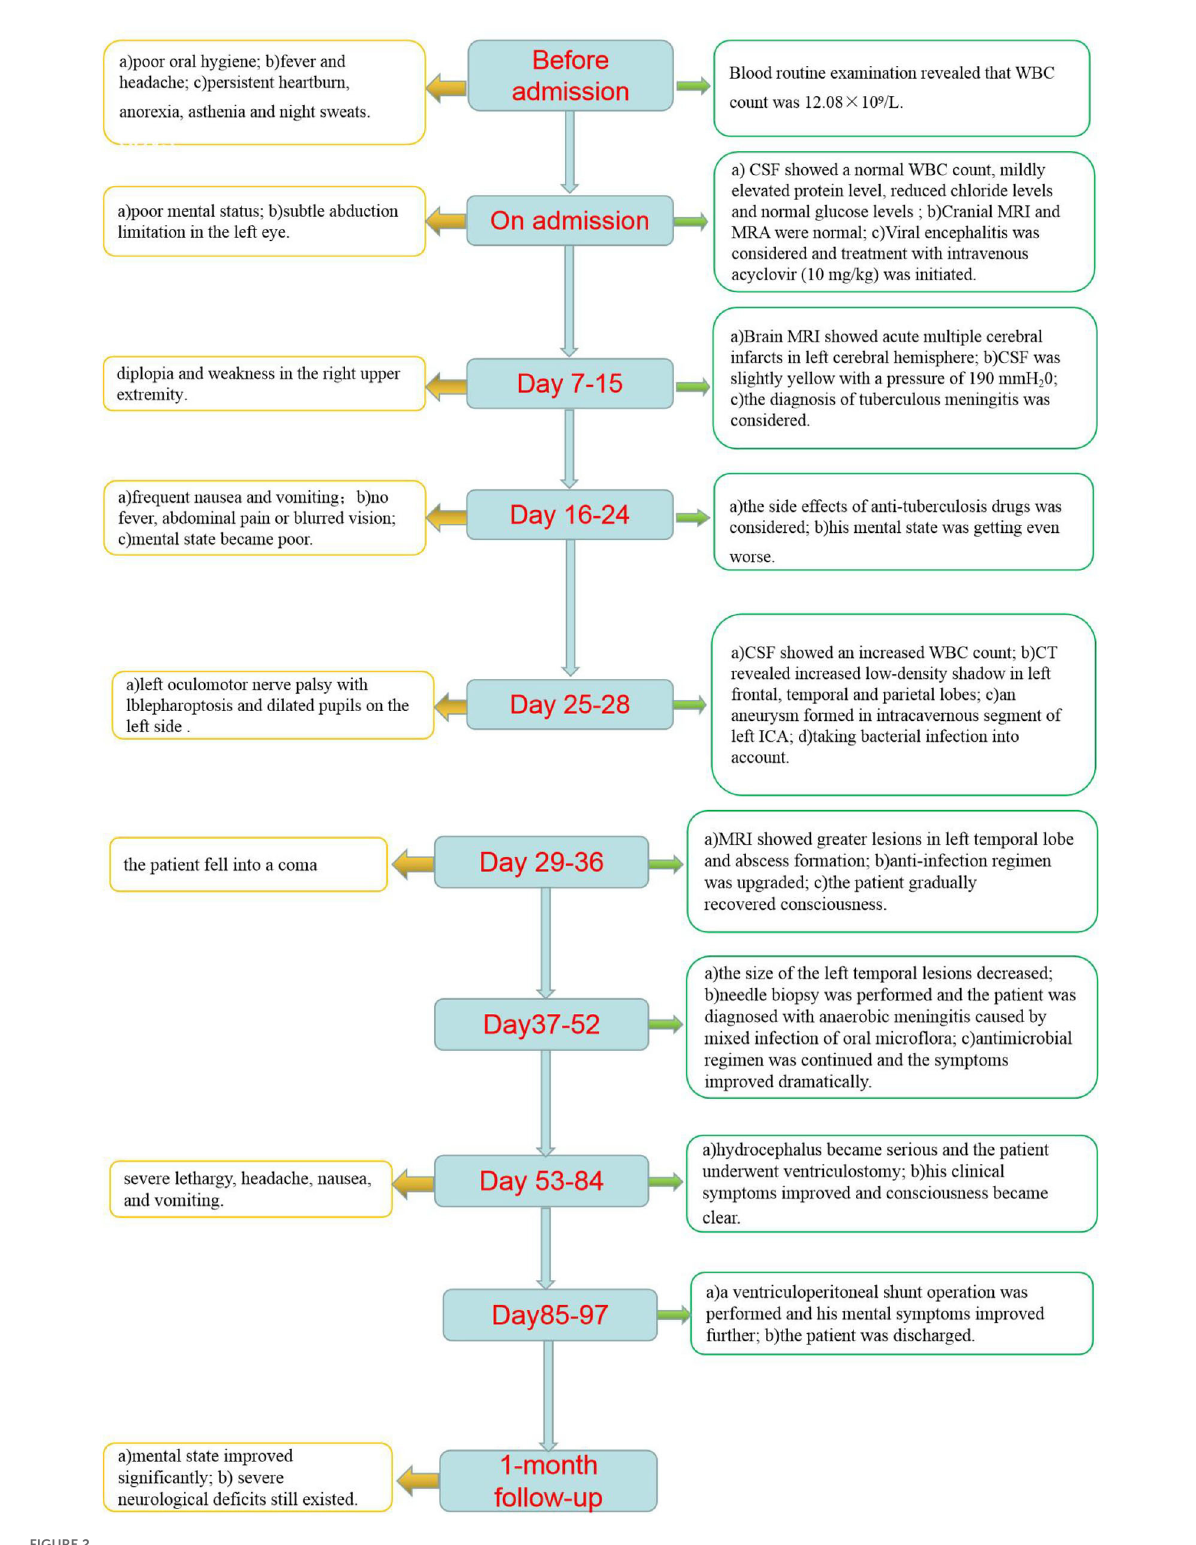
FIGURE2 Clinical course of the